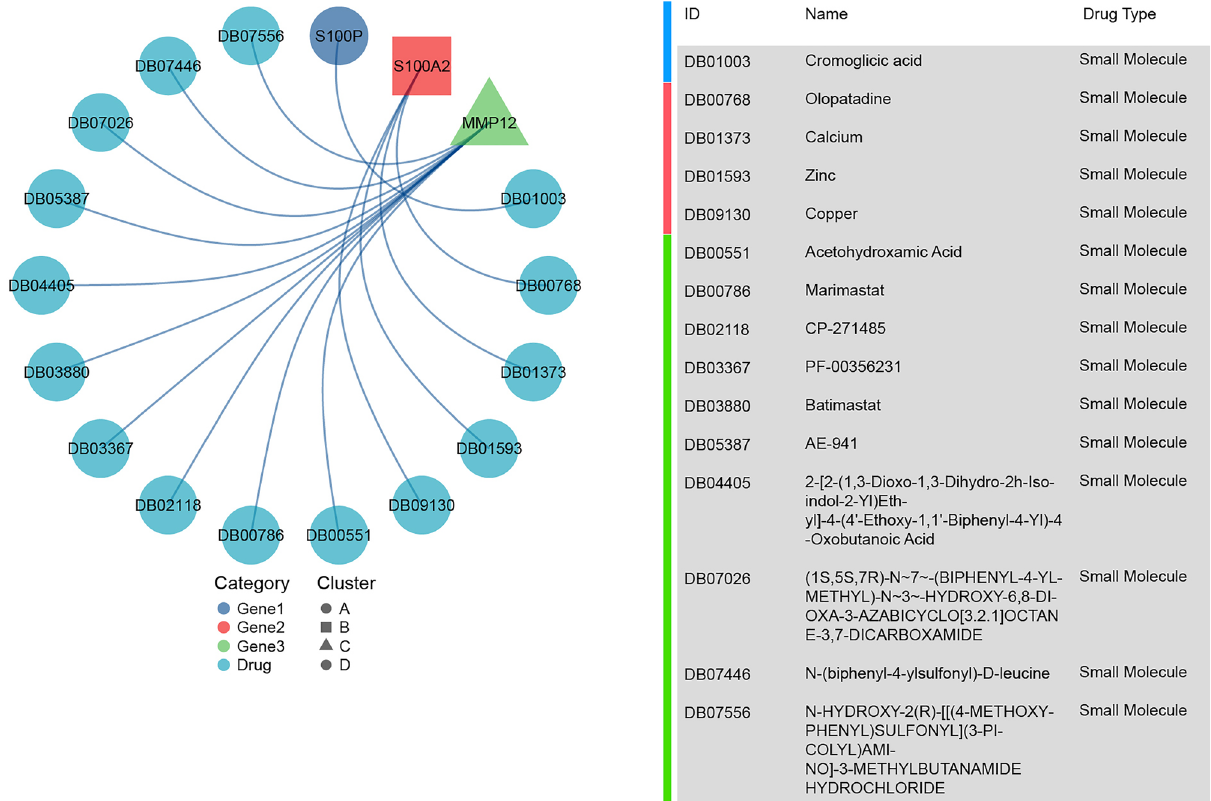
Figure 15. Prediction of PAAD-IRGS associated drugs. The network plot showed several potential drugs targeted with the